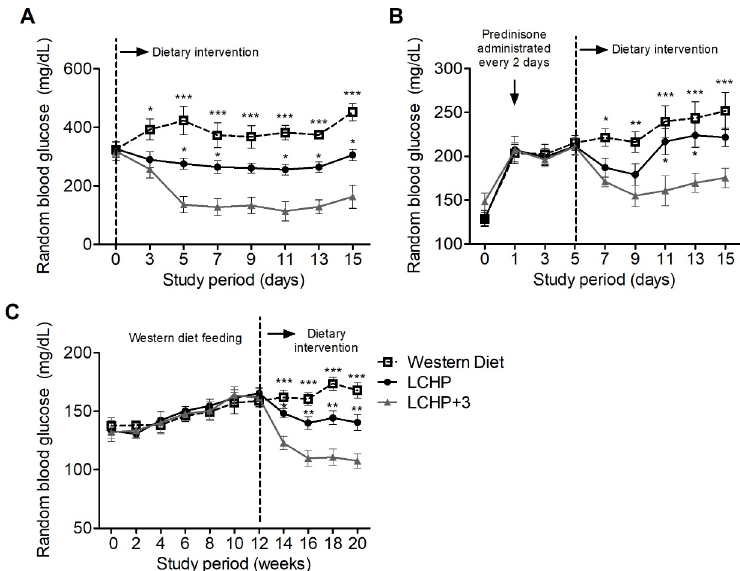
Figure 4. Effects of the LCHP+3 dietary intervention on random blood glucose levels in disease models of hyperglycemia. Three models of hyperglycemia were studied: ( A ) Streptozotocin-induced type 1 diabetes; ( B ) Steroid-induced diabetes-like hyperglycemia; ( C ) Western diet-induced metabolic syndrome. After hyperglycemia induction, the mice were randomly allocated into three groups and fed a control Western diet, the LCHP diet, or the LCHP+3 diet. Values are shown as mean ± SEM. Compared with the LCHP+3 group, * p < 0.05, ** p < 0.01, *** p < 0.001; n = 6 per